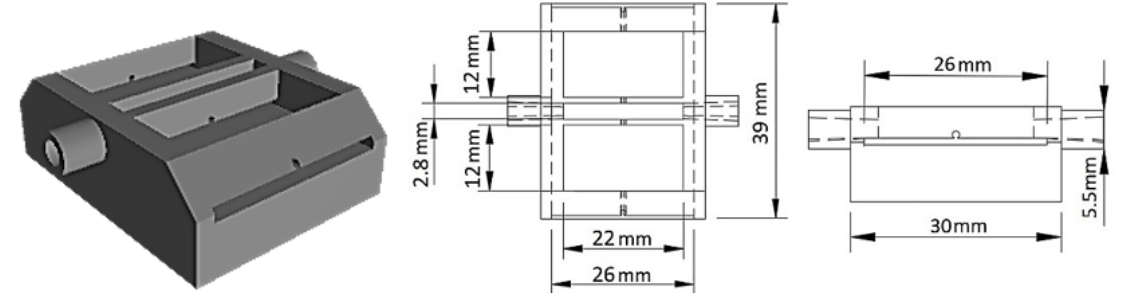
Figure 1. Microfluidic chip design and dimensions.